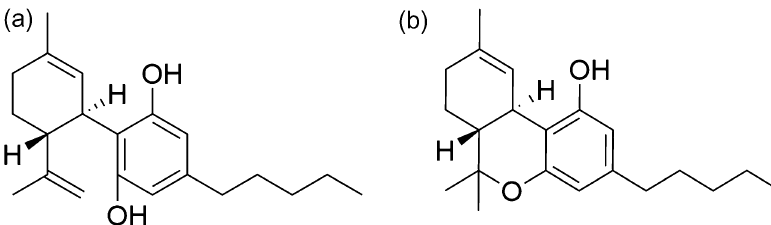
Figure 1. ( a ) Cannabidiol and ( b ) Tetrahydrocannabinol—structural representation of CBD and THC. Formula: C 21 H 30 O 2 ; Molecular weight: 314.464